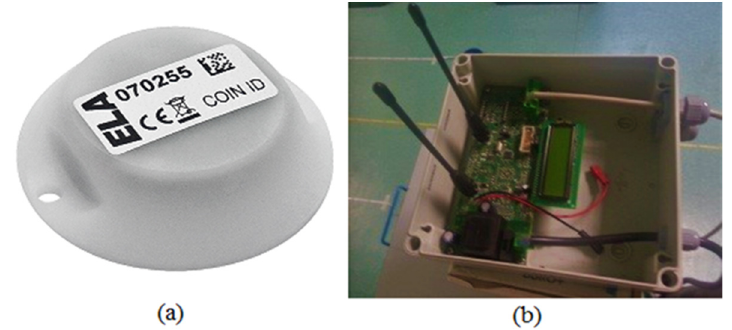
Figure 5. (a) Coin ID RFID tag and (b) UTP Diff 2 RFID reader.